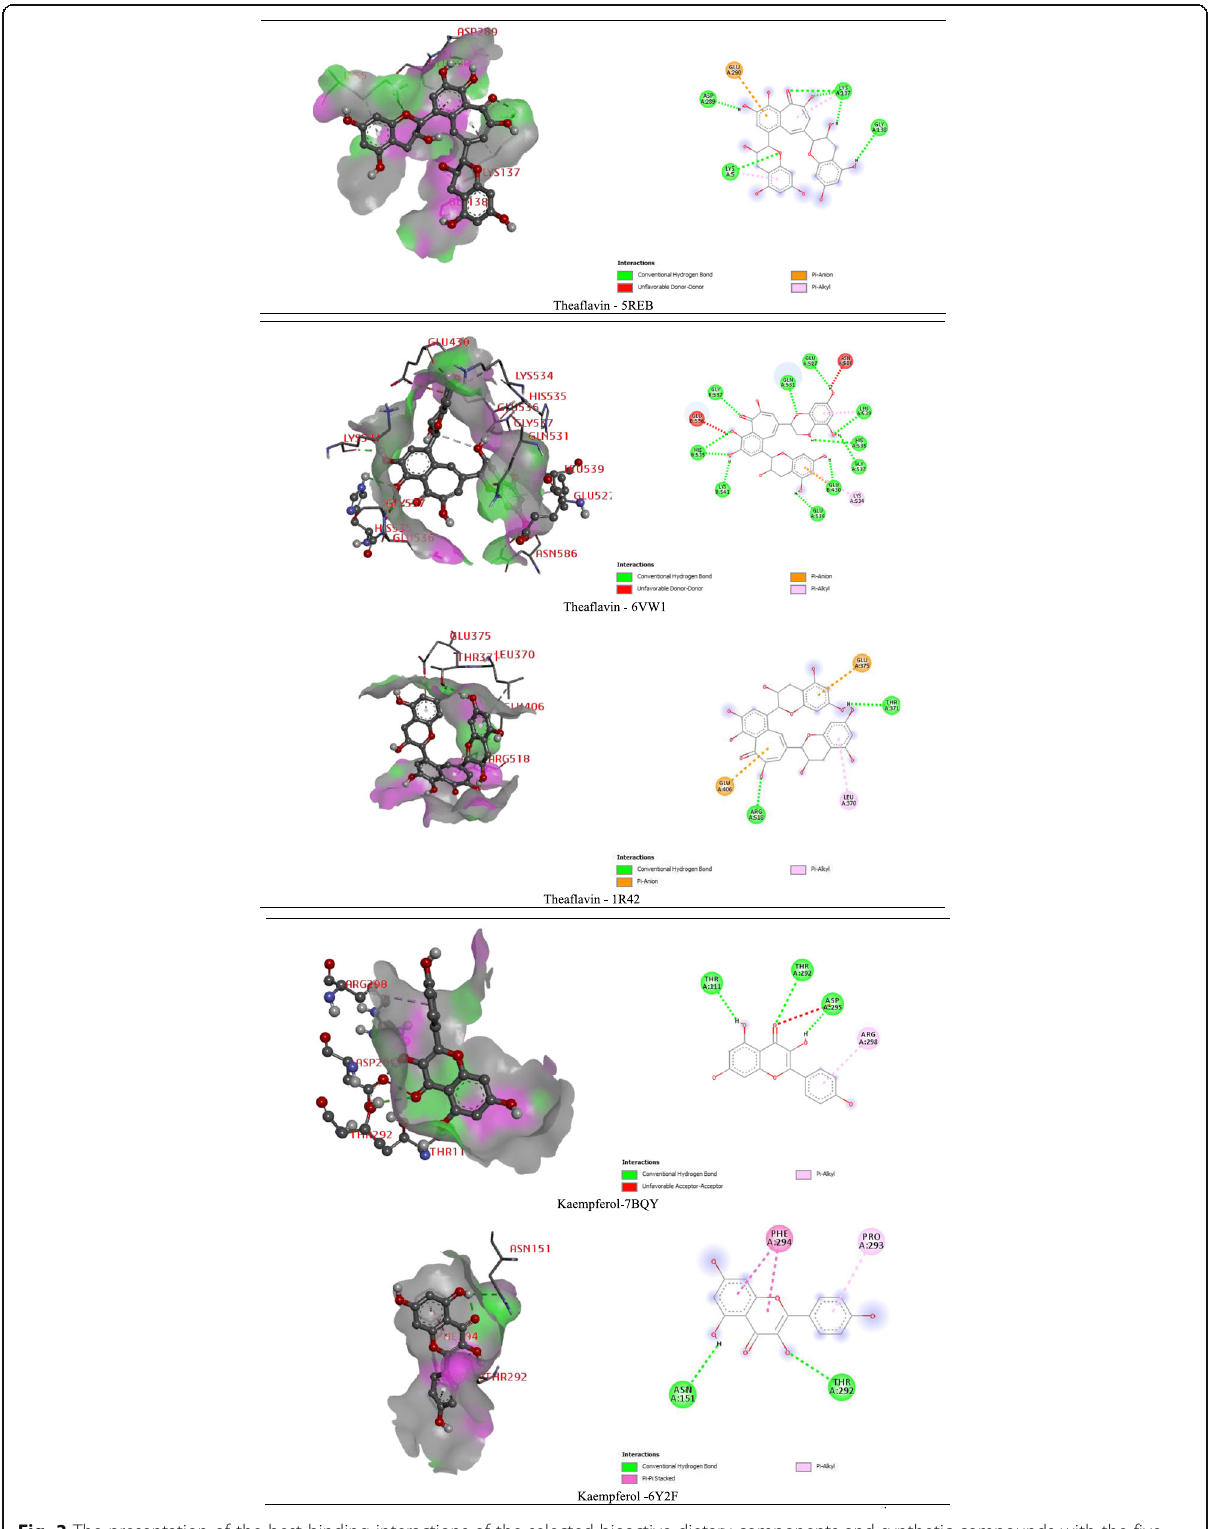
Fig. 3 The presentation of the best binding interactions of the selected bioactive dietary components and synthetic compounds with the five SARS-CoV-2 proteins (main protease and angiotensin-converting enzyme 2